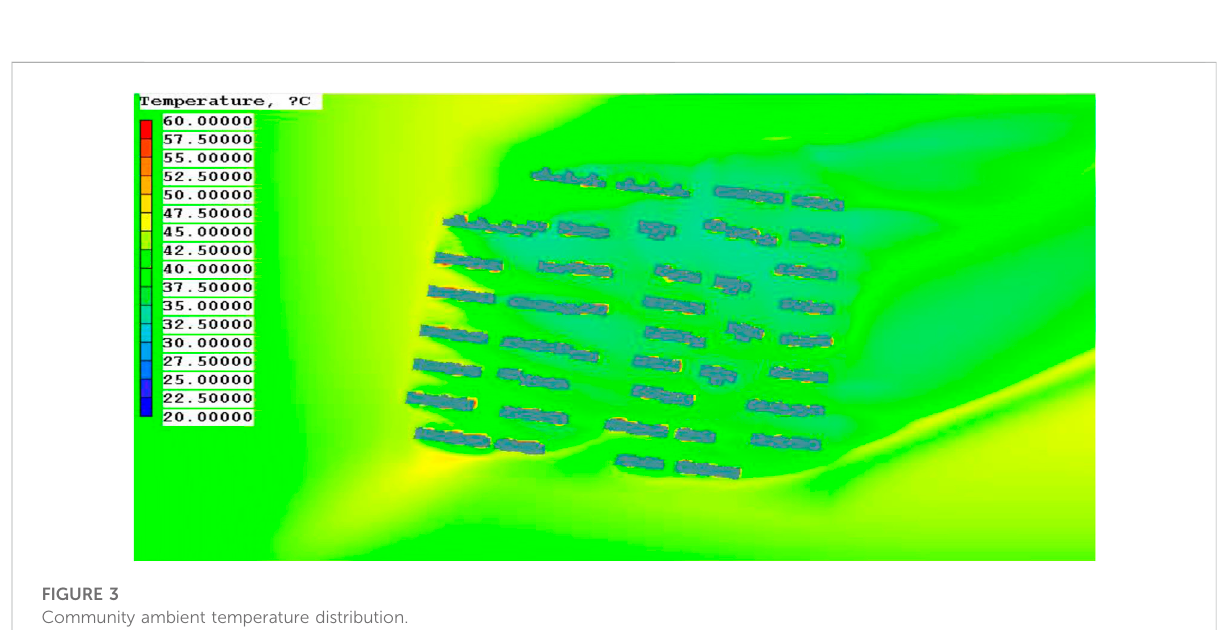
FIGURE 3 Community ambient temperature